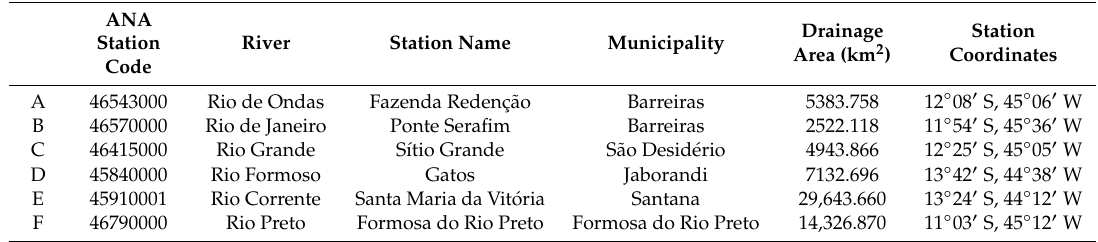
Table 1. Selected river flow stations. The letters correspond to the labels of stations in Figure